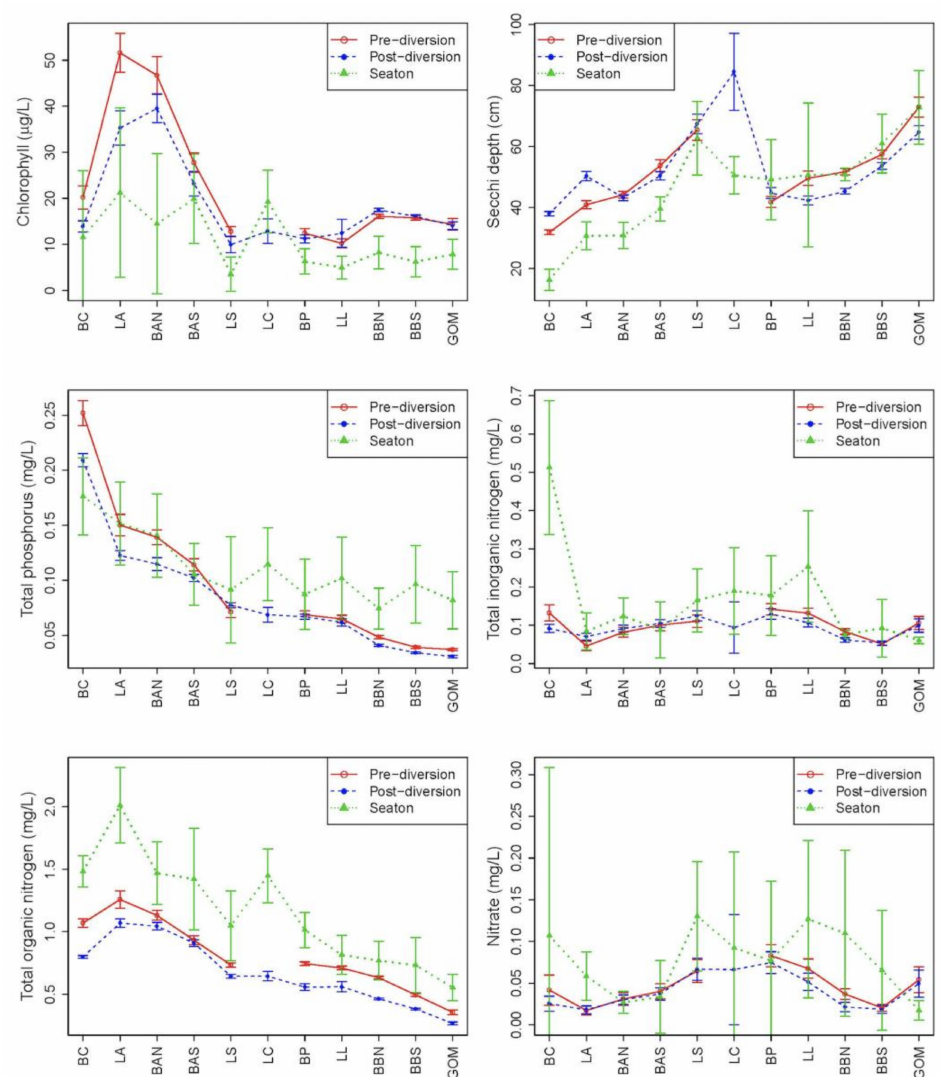
Figure 7. A comparison of water quality parameters from transects of the Barataria Basin from [45,46] and [16,18]. The means are geometric and standard error bars arithmetic. Station designations are defined in Figure 3. Data collected for